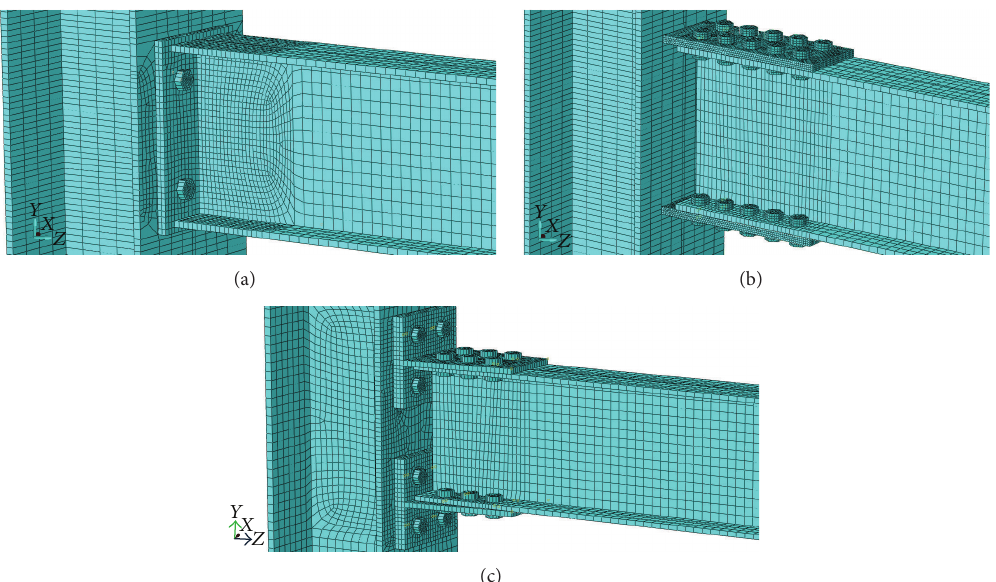
Figure 6: Mesh of studied connections: (a) connection to the end plate; (b) connection with the bolted cover plate; (c) bolted T joint.